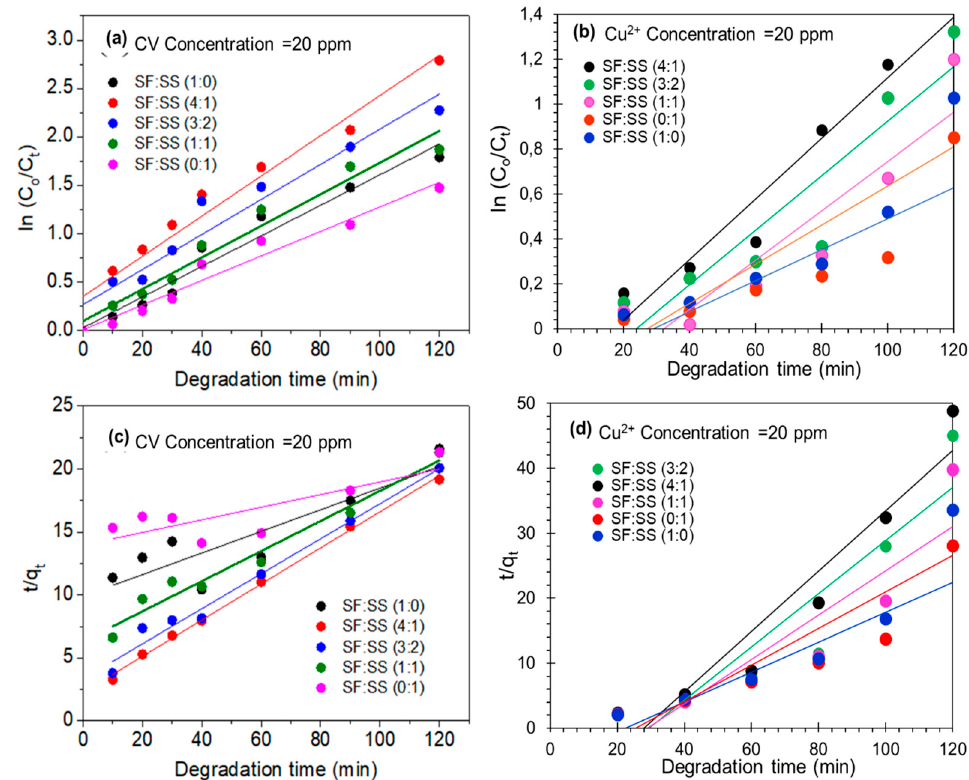
Figure 6. The linear dependence of C t /C 0 on t based on the pseudo-first-order model for ( a ) CV and ( b ) Cu 2+ adsorption, and ( b ) the linear dependence of t/Q t on t based on the pseudo-second-order model for ( c ) CV and ( d ) Cu 2+ adsorption.